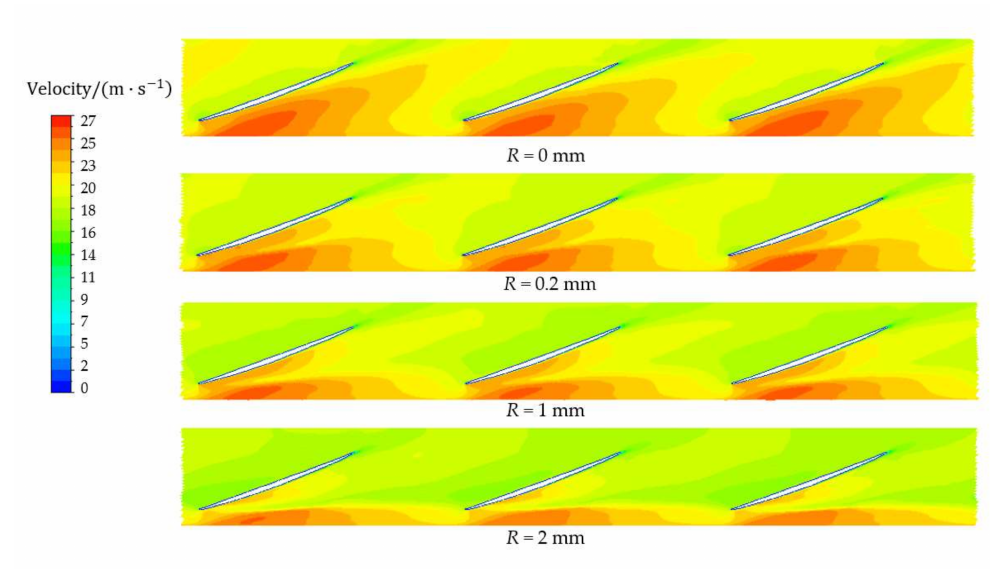
Figure 14. Cylindrical distribution of impeller internal velocity under pump condition ( r ∗ = 0.97).